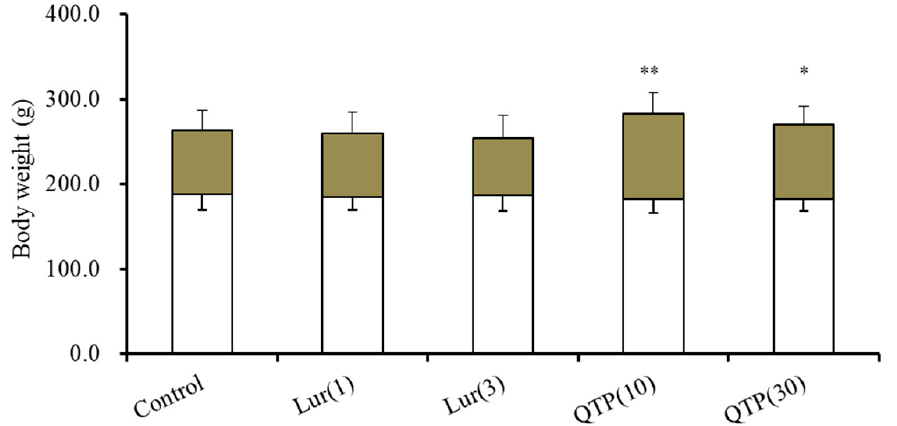
Figure 1. Impacts of chronic administration of quetiapine (10 and 30 mg/kg/day for 14 d) and lurasidone (1 and 3 mg/kg/day for 14 d) on rat body weight. Ordinate indicates mean ± standard deviation (SD) ( n = 6) of rat body weight (g). Opened and brown columns indicate the rat body weight before (6 weeks of age) and after (8 weeks of age) the chronic administration of antipsychotics, respectively. *: p < 0.05, **: p < 0.01: relative to control (vehicle alone: MRS containing 0.1% DMSO) by analysis of variance (ANOVA) with Tukey’s post hoc test.